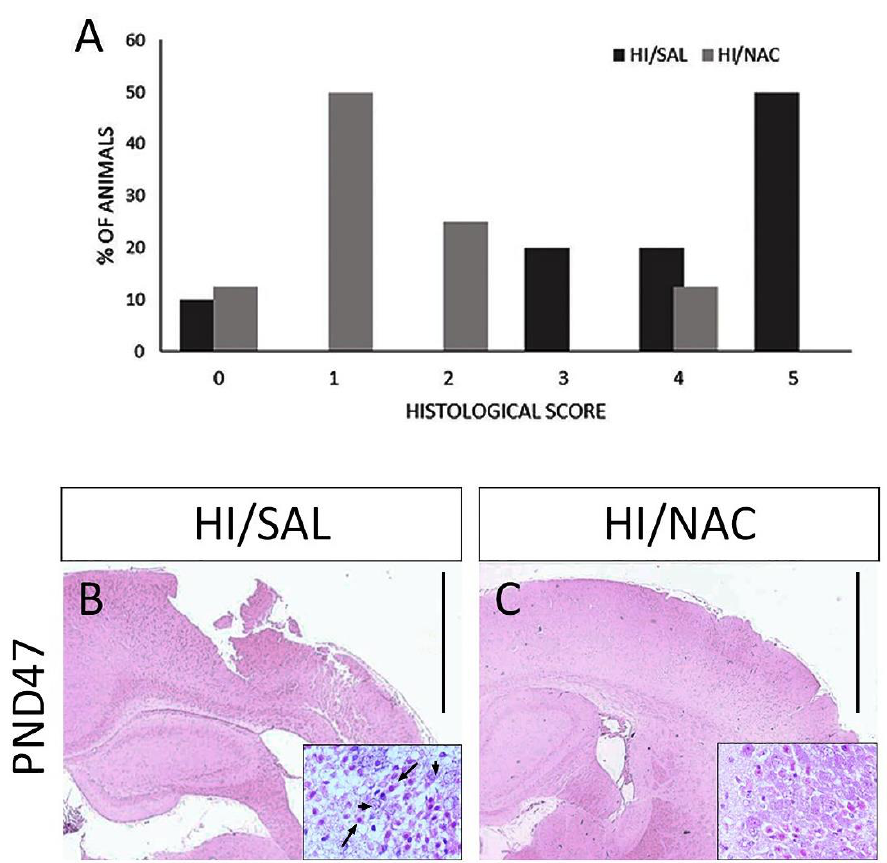
Figure 4. Effect of neonatal HI and NAC administration on brain damage. ( A ) Percentage of animals according to various degrees of brain damage based on a 6-point scale. Representative coronal brain sections of HI/SAL and HI/NAC-treated rats at 7 weeks following neonatal HI under H&E staining. Extensive damage of the ipsilateral cerebral cortex is observed in HI/SAL group ( B ). In HI/NAC group, brain damage is significantly limited and cerebral cortex is preserved ( C ). Scale=100 μm. CA1 region of hippocampus is shown under higher magnification ×40. Black arrows indicate damaged neurons with eosinophilic cytoplasm and pyknotic nucleus. Arrowheads indicate neurons with relatively normal